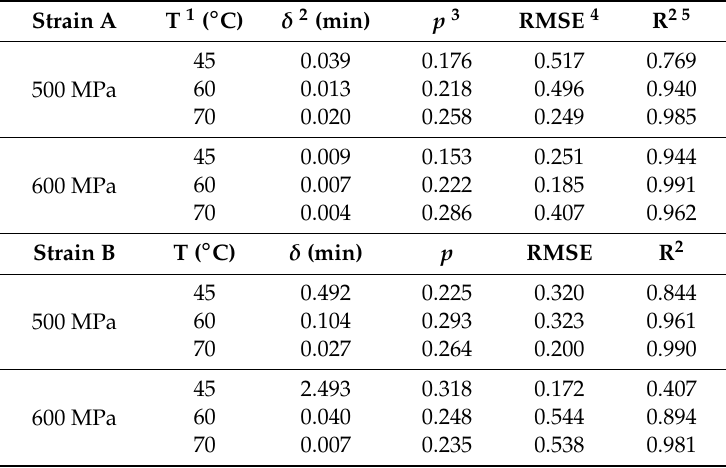
Table 1. Weibull model-estimated kinetic parameters and goodness-of-fit indices for the inactivation of A. acidoterrestris spores for Strains A and B using temperature-assisted high-pressure